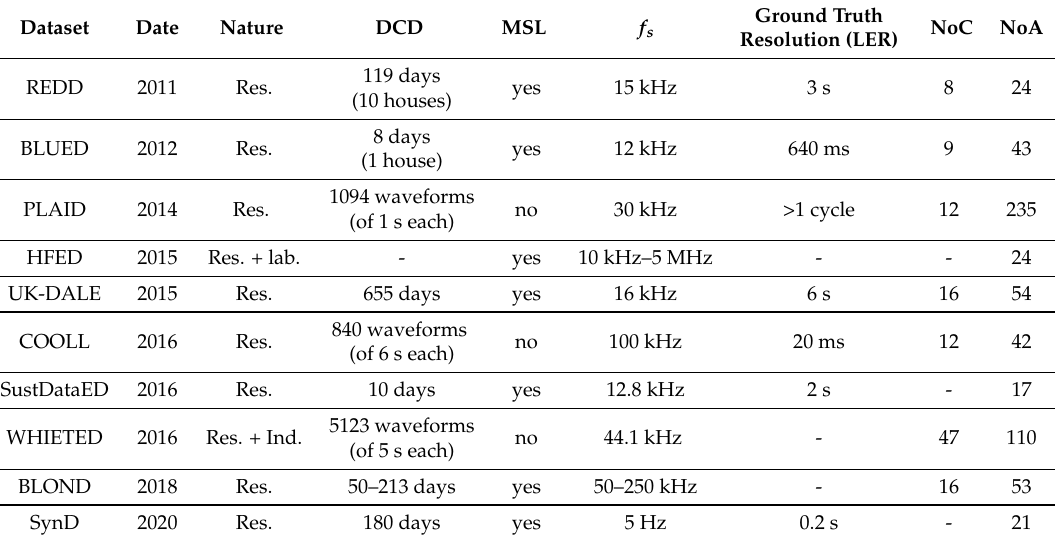
Table 3. Comparison between high-frequency NILM